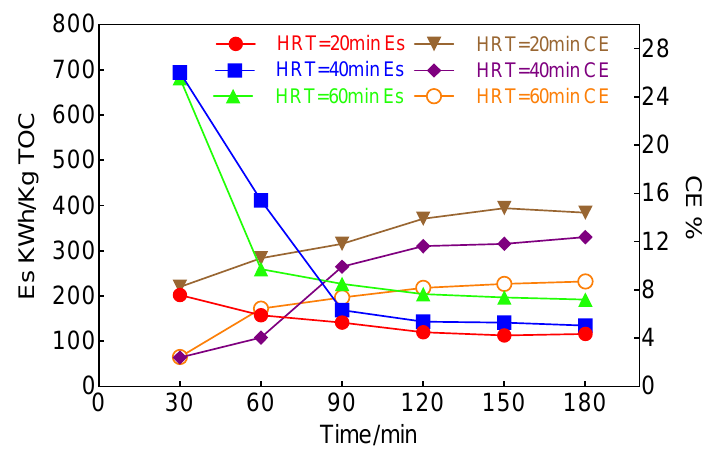
Figure 12. Es and CE of the recycling-flow 3D electro-reactor system at different HRTs (RhB wastewater initial concentration is 100 mg/L; volume is 500 mL; initial pH is 7; Na 2 SO 4 as an electrolyte, initial concentration is 2 g/L; voltage is 5 V; current density is 60 mA/cm 2 ).